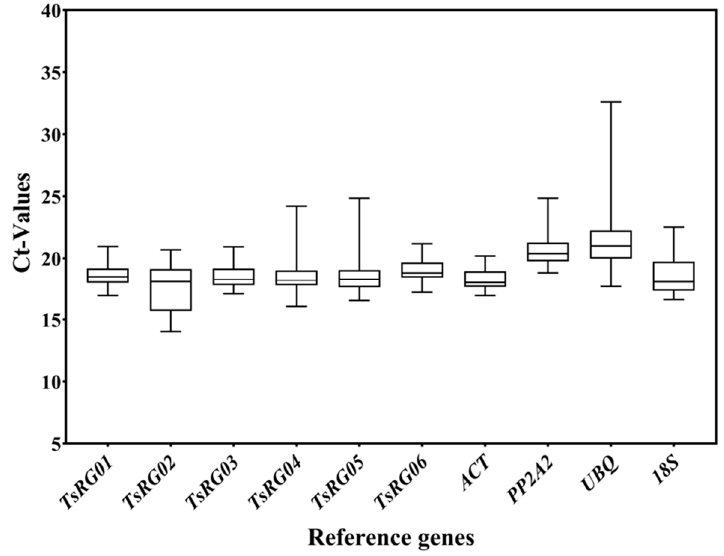
Figure 1. The expression levels of 10 candidate RGs across all experimental samples. The box plot represents the distribution interval of Ct values of 10 RGs in all samples: the upper side represents the upper quartile (75%), the middle line represents the median (50%), the lower side represents the lower quartile (25%), the upper edge represents the maximum value of sample data, and the lower edge represents the minimum value of sample data.